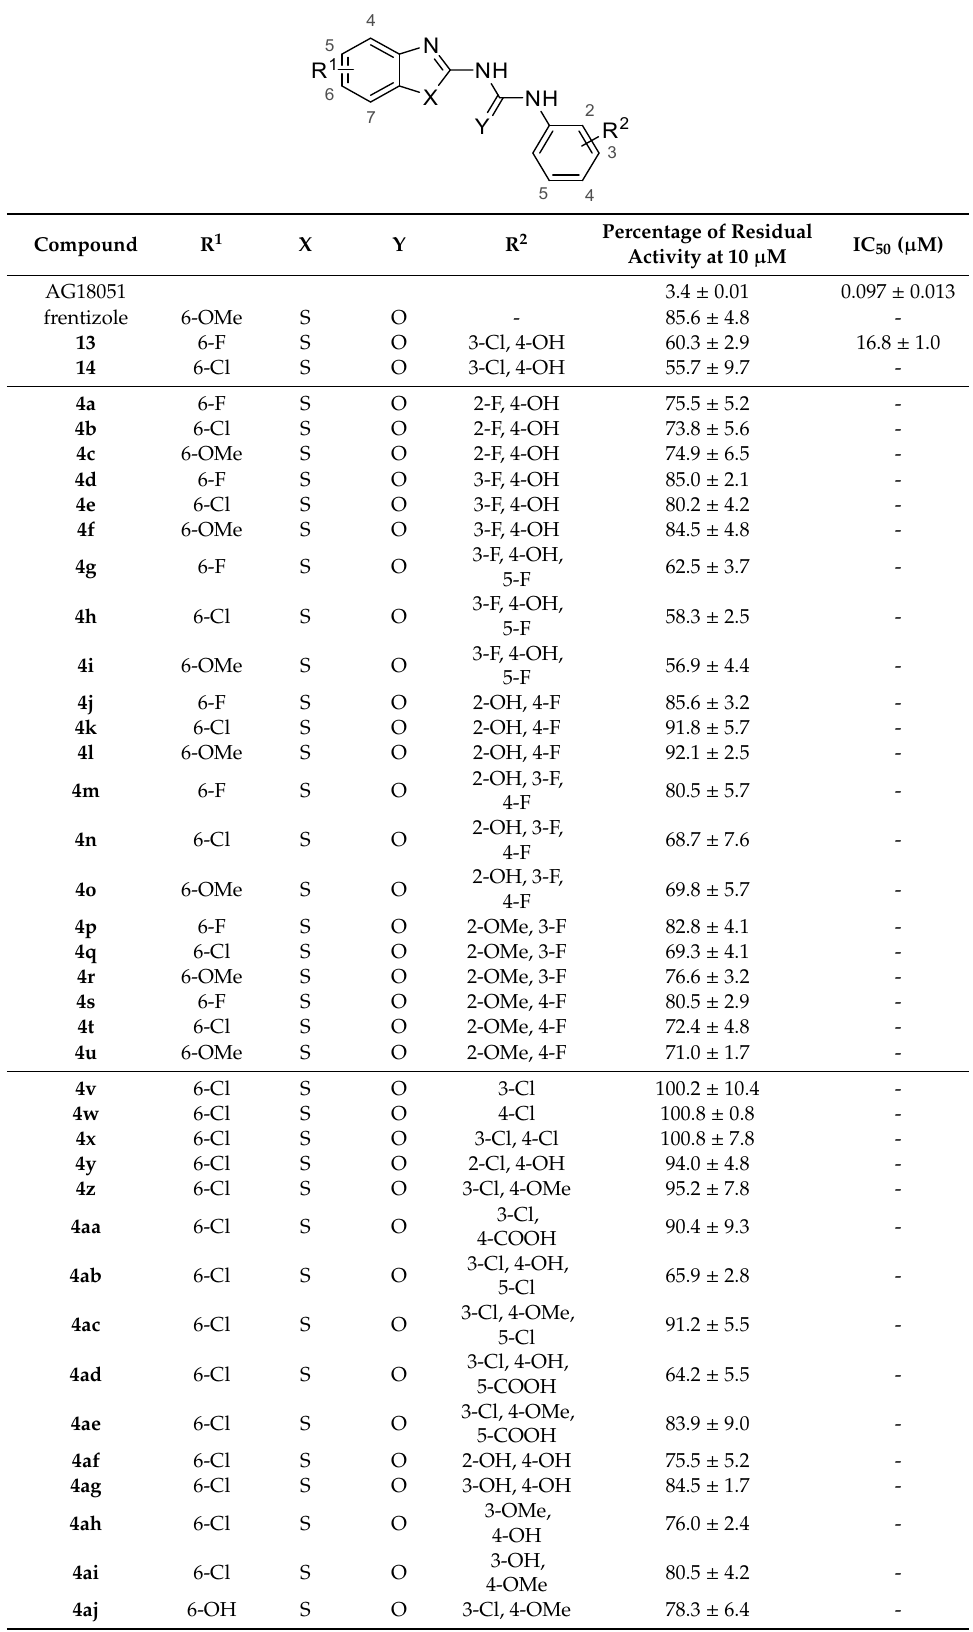
Table 1. List of synthesized compounds and their in vitro inhibitory potency against the human 17 β -HSD10 enzyme.